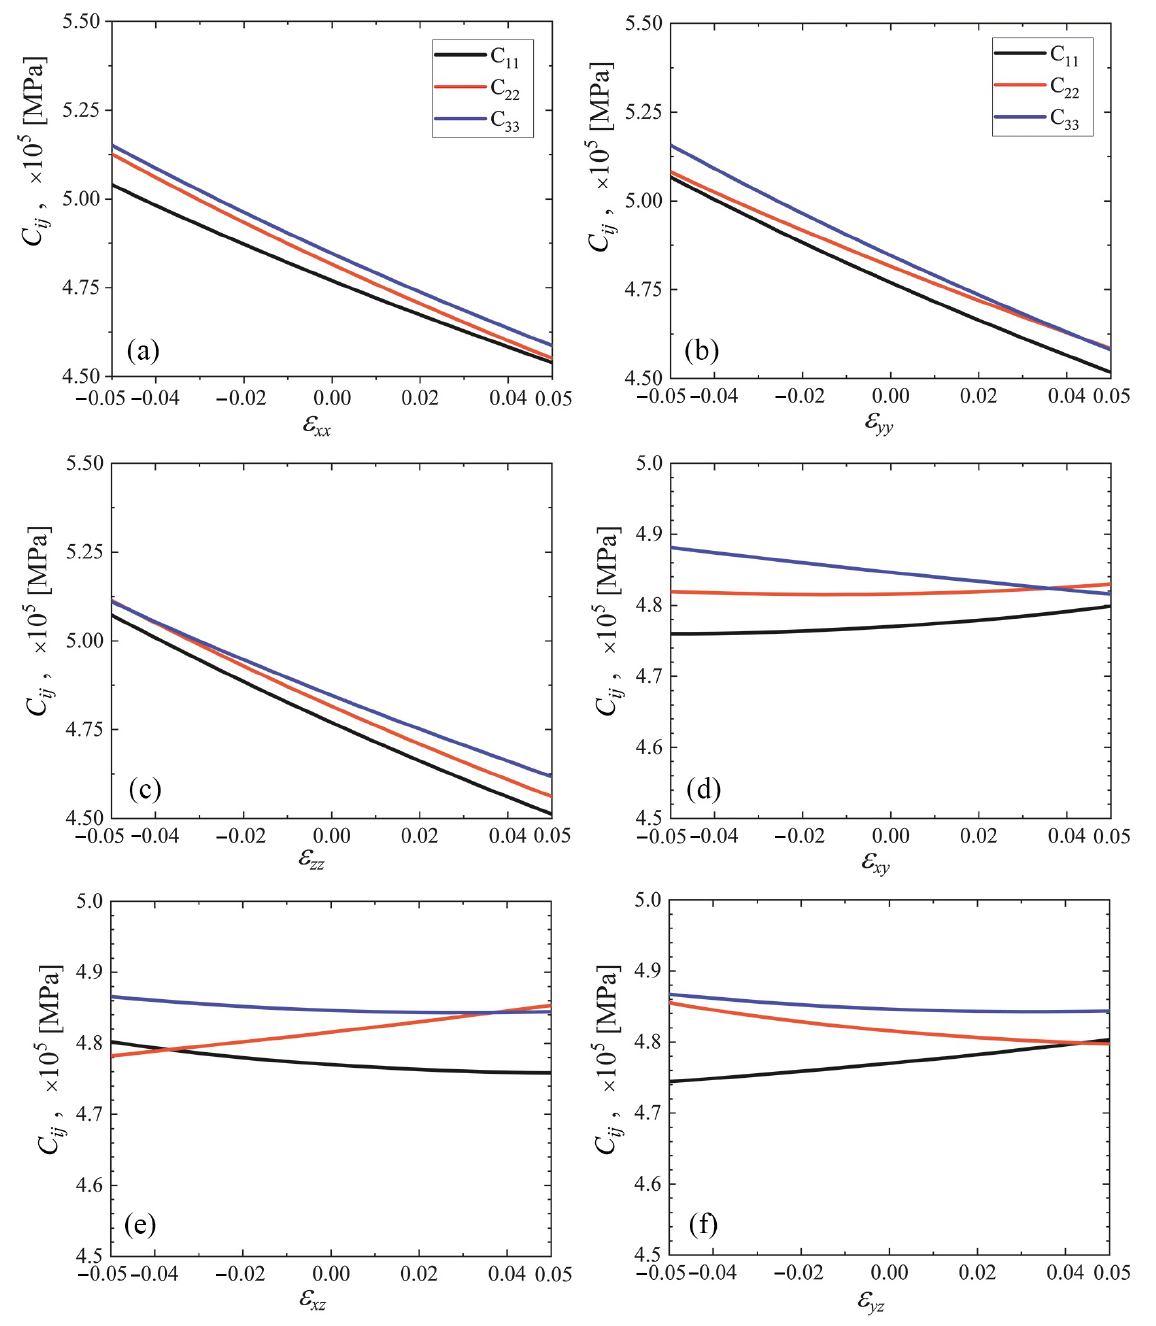
Figure 8. The same as in Figure 7, but for the triclinic crystal. Panels ( a – f ) correspond to changing ε xx to ε yz ,